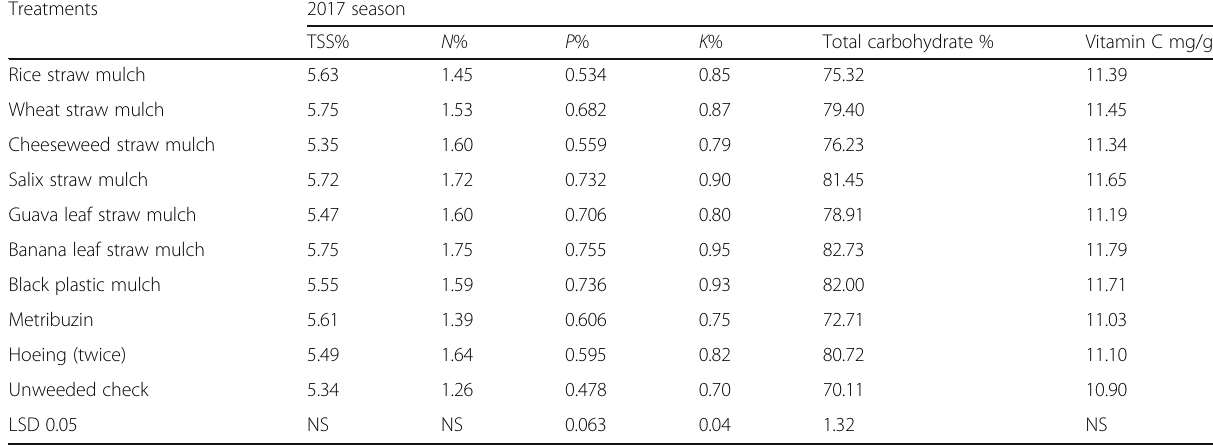
Table 6 Effect of different weed control treatments on tuber quality of potato during 2017 season Treatments